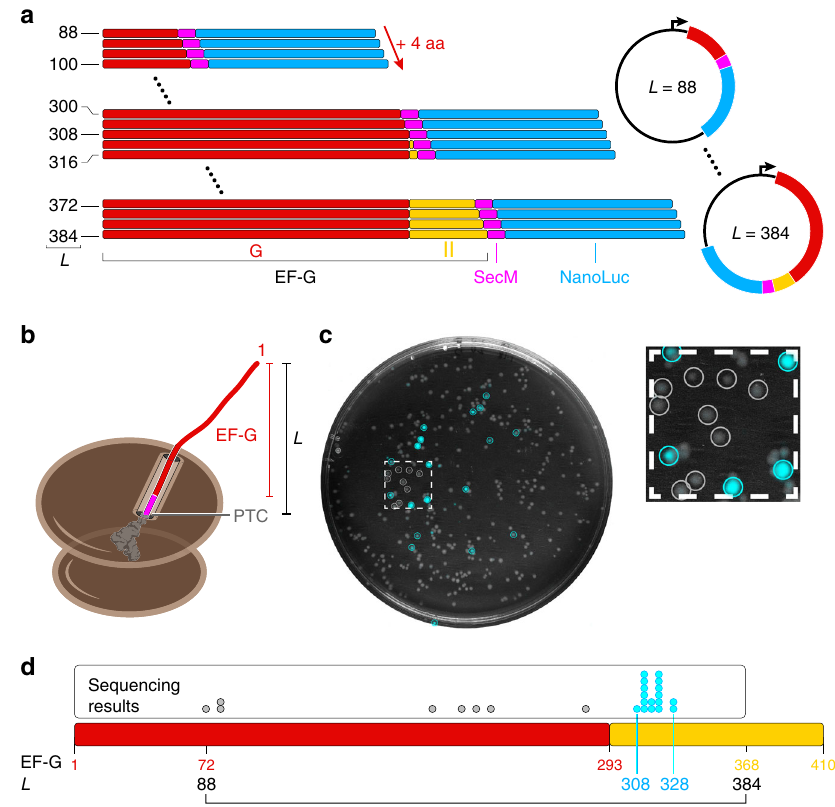
Fig. 3 On-plate screening identi fi es nascent chain folding in a pool of constructs. a Construction of a plasmid pool containing increasingly longer EF-G candidate polypeptides. The shortest construct encodes 72 N-terminal amino acids of the G-domain (red), followed by the SecM arrest sequence ( L = 88); the longest construct encodes the full G-domain plus 75 amino acids from domain II (yellow), followed by the SecM arrest sequence ( L = 384). b Cartoon illustrating the nomenclature for the plasmid pool. The length L represents the number of amino acids from the peptidyl-transferase center (PTC) of the ribosome to residue 1 of the EF-G candidate. c Merged bright fi eld image of the agar plate (grayscale) and colony luminescence (cyan). The inset shows a magni fi cation of the boxed region. Colonies selected for sequencing are circled. d Colony sequencing results. Each dot represents the sequencing result from an individual colony, mapped to the length of the EF-G candidate sequence (bar diagram). All constructs yielding high luminescence (cyan dots) cluster in the region 308 ≤ L ≤ 328. All nonluminescent samples have shorter chain lengths (gray dots). Red and yellow numbers indicate residue positions in the EF-G amino acid sequence.